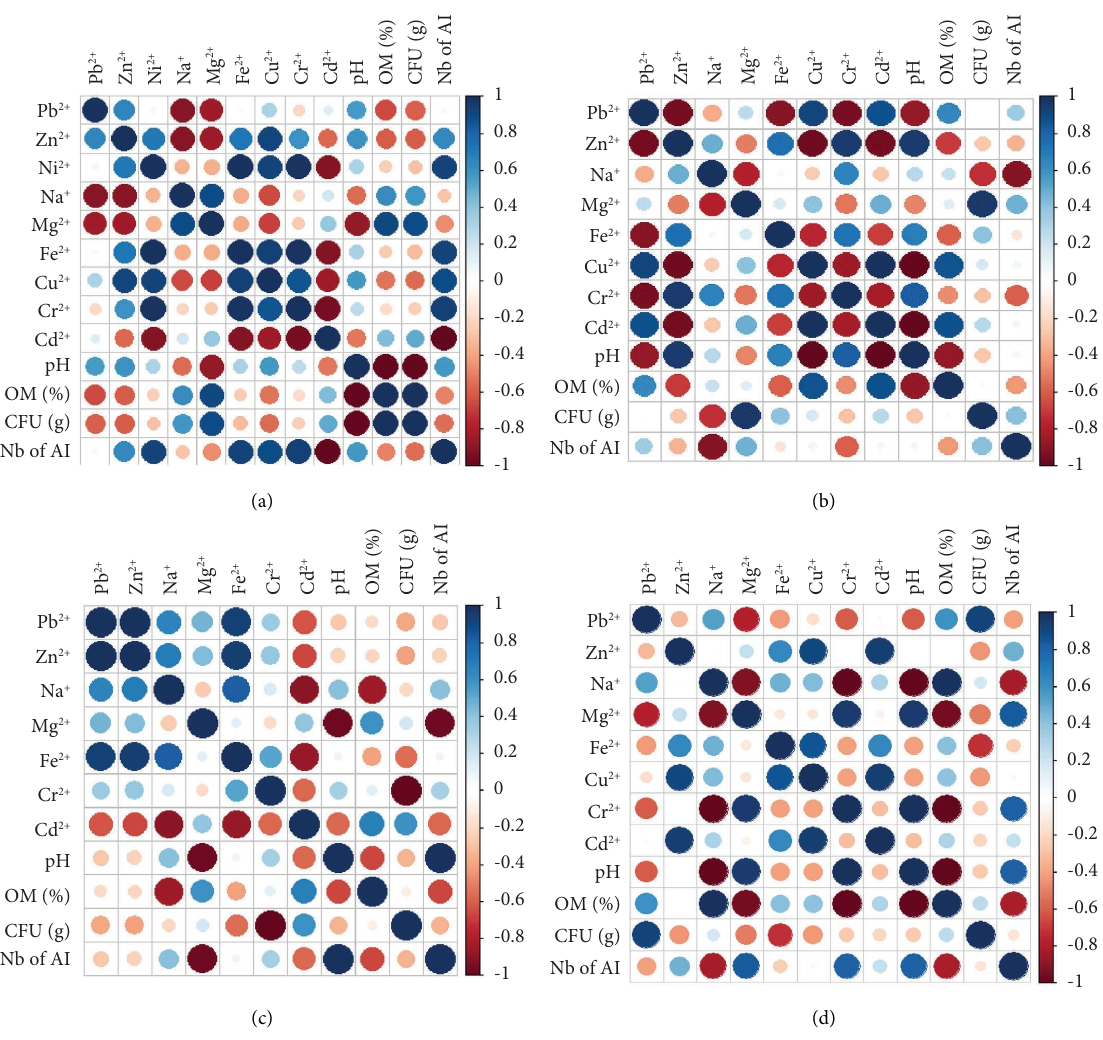
Figure 2: Correlation analysis between heavy metals, pH and organic matter of soil samples, and the bacterial concentration and Actinobacteria isolates in sites. (a) Ahouli. (b) Mibladen. (c) Midelt. (d) Zaida. OM: organic matter; CFU: colony-forming unit; Nb of AI: number of Actinobacteria isolates. Concentrations of Pb, Zn, Ni, Na, Mg, Fe, Cu, Cr, and Cd were given in mg/kg of